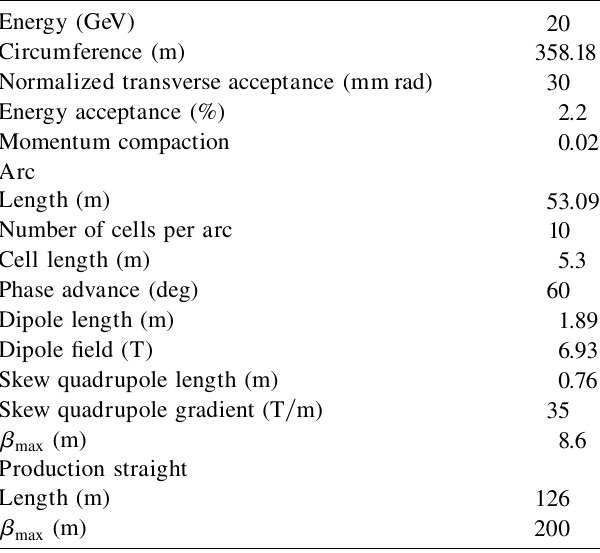
TABLE XI. Muon storage ring parameters.